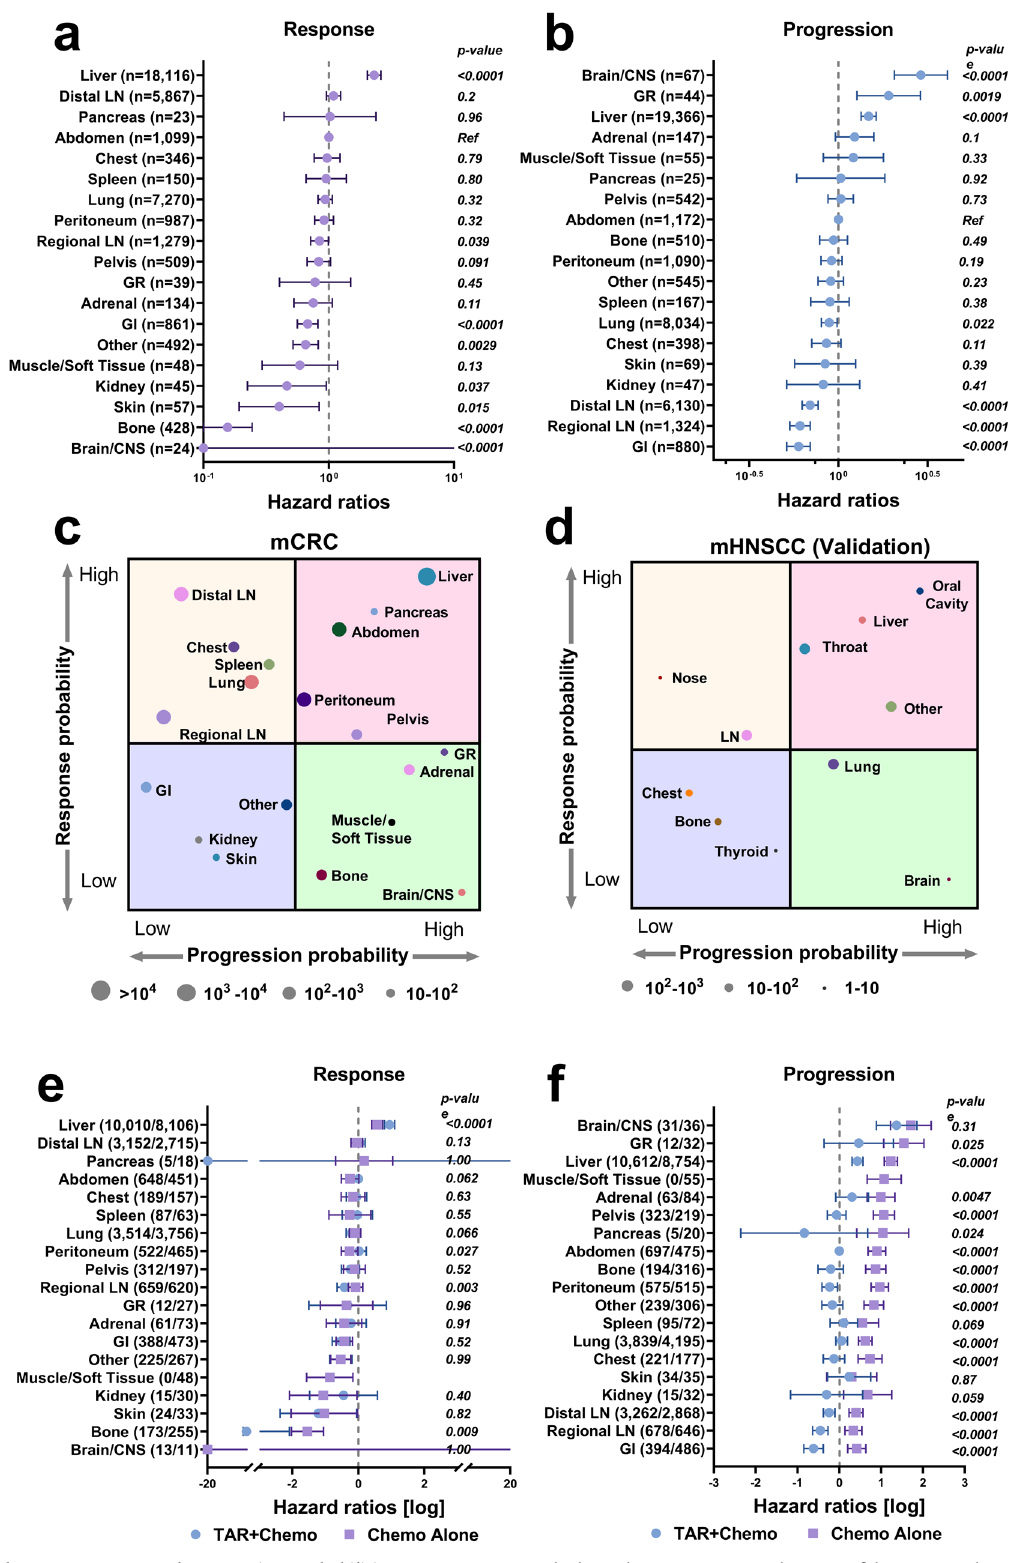
Fig. 3 | Organ-level tumor response and progression probabilities suggest phenotypic convergence. a , b Data are presented as the hazard ratio estimates with 95% con fi dence interval by organs on lesion response and progression in colorectalcancerpatients. c , d aretheanatomicalchartsoforgan-speci fi cresponse and progression hazard ratios in metastatic colorectal cancer (mCRC) and meta- staticheadandnecksquamouscellcarcinomas(mHNSCC). e , f Dataarepresented